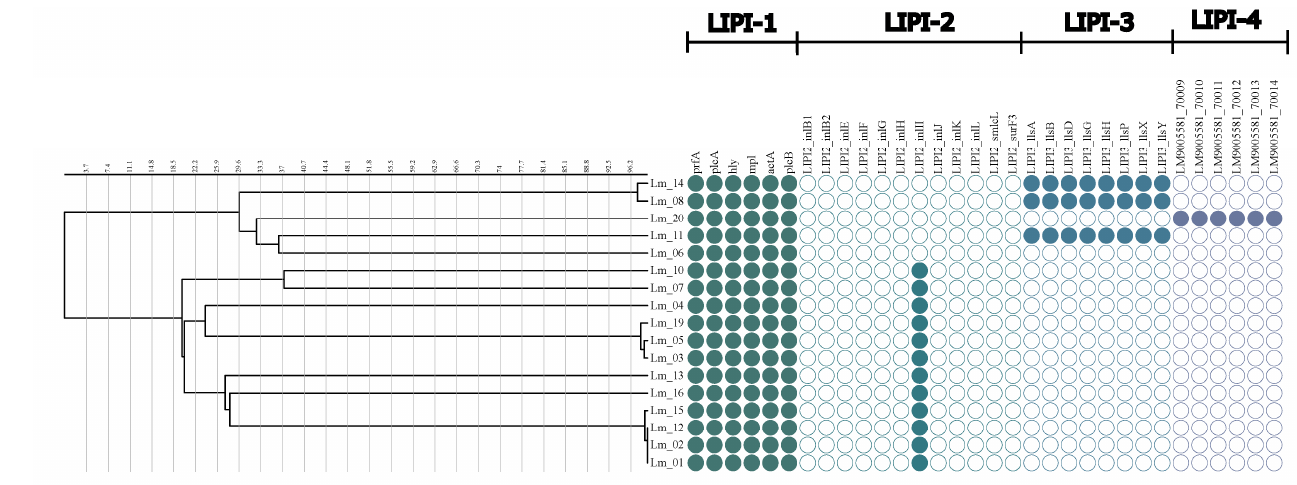
Figure 3. Dendrogram constructed with cgMLST data for the 17 L. monocytogenes isolates with gene content